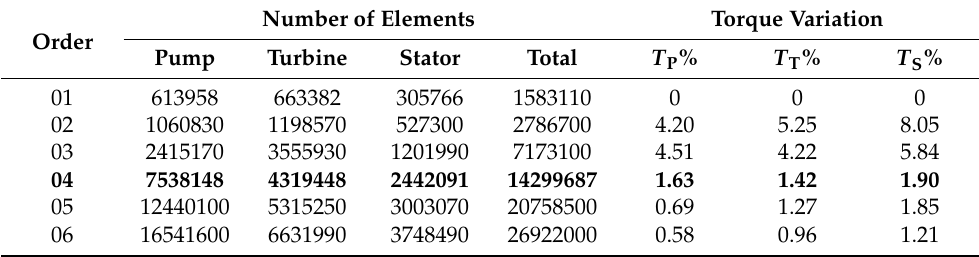
Table 1. Data of the mesh independence